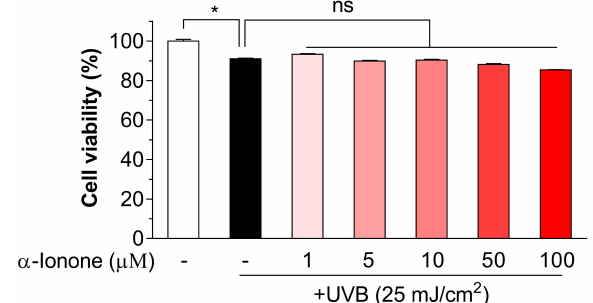
Figure 1. α -Ionone has no toxicity to UVB-exposed human dermal fibroblasts. A cytoprotective e ff ect of α -ionone was determined by the 3-(4,5-dimethylthiazol-2-yl)-2,5-diphenyltetrazolium bromide (MTT) assay. Cell viability (%) was calculated as follows: (A570 of treated cells / A570 of untreated cells) × 100, where A570 is absorbance at 570 nm. Values are presented as means ± SEM (n = 3). Significant di ff erences between groups are indicated by asterisks: * P < 0.05; ns, not significant ( P >